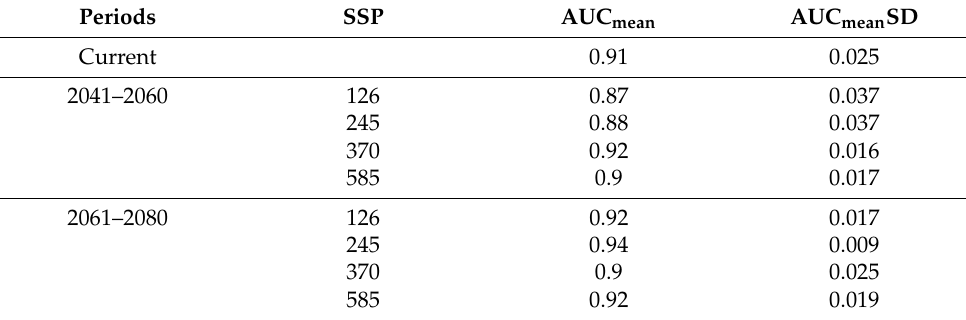
Table 2. Mean AUC values (AUCmean) and standard deviation of the mean AUC values (AUCmeanSD) for the current and future MaxEnt models for Eurasian Pygmy Owl’s distribution under different SSP